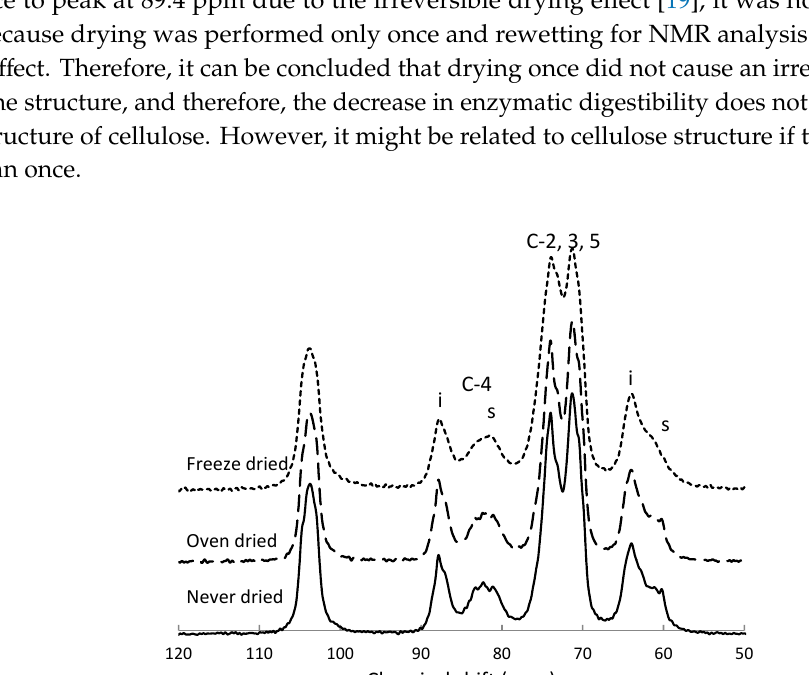
Table 4. Amount of adsorbed dye depending on drying methods.